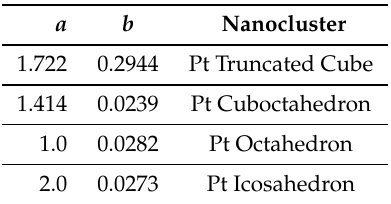
Table 3. Linear constants for D ( n ) .